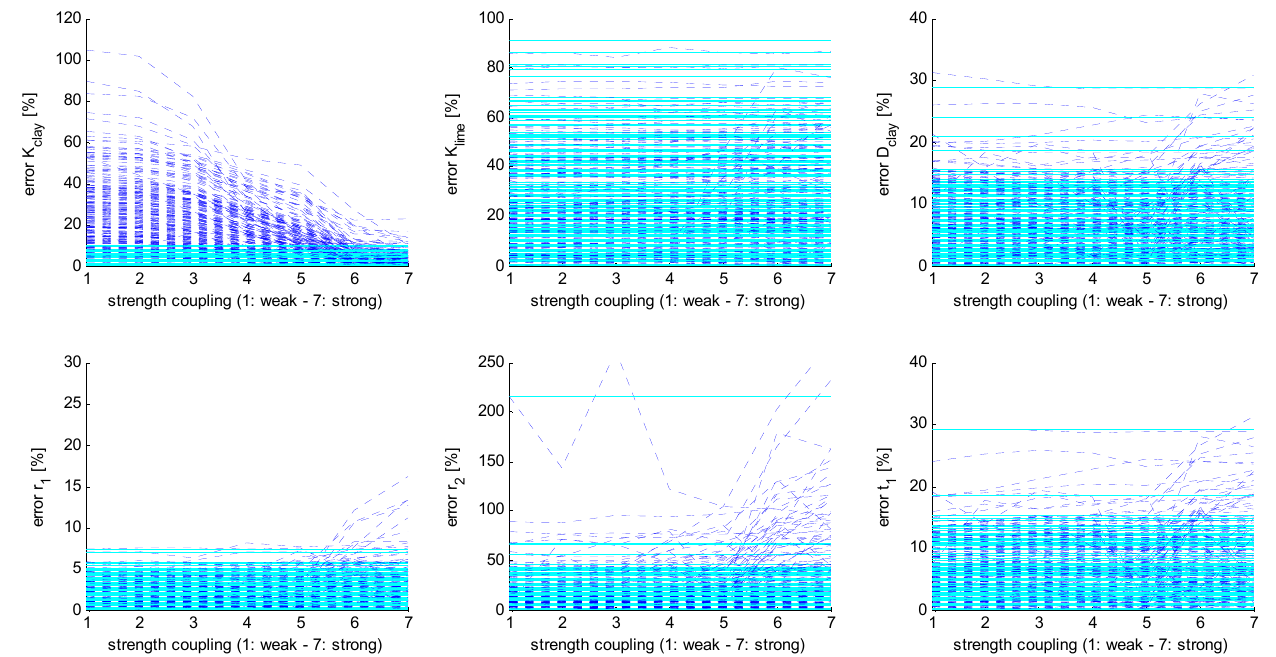
Fig. 3. Parameter errors for JHI Runs 1–7 for 250 realizations and increasing weight for the coupling constraints (blue dashed lines). The cyan lines indicate the parameter errors for the 250 SHI runs. Groundwater model parameters are shown in the upper row of figures, geophysical parameters on the bottom row. Standard deviations of the JHI coupling constraints, e c , are listed in Table